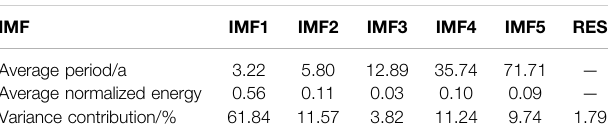
TABLE 1 | Mean cycle, average normalized energy, and variance contribution rates of IMF components of MTDI for 1901 – 2016 based on EEMD decomposition.